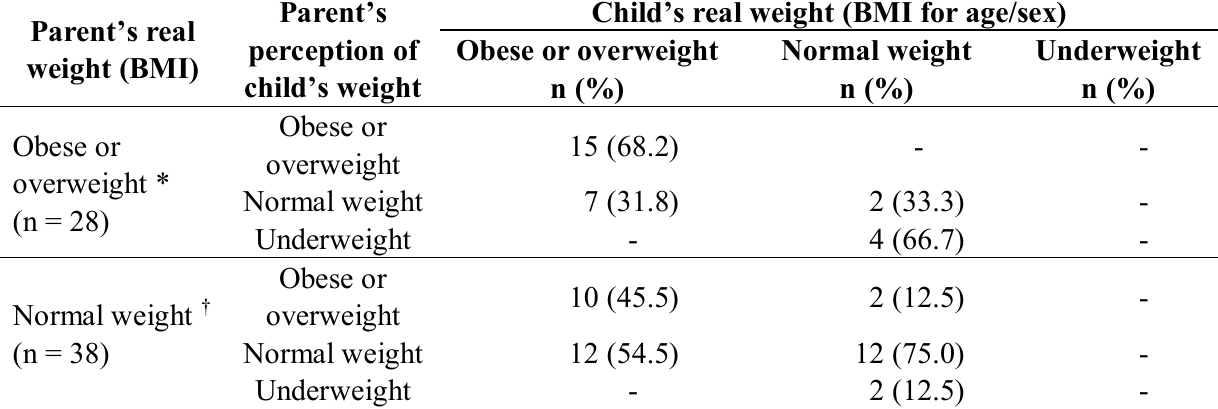
Table 4. Relationship between Child’s Real and Perceived Weight Status by Parental Weight Status among Elementary School Students, Cayey, Puerto Rico,